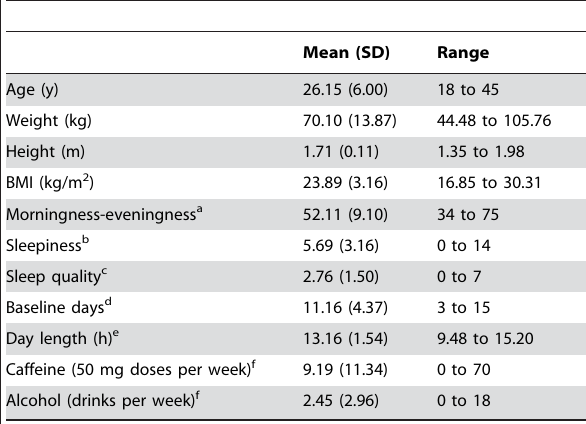
Table 1. Means, standard deviation and range of continuous demographic